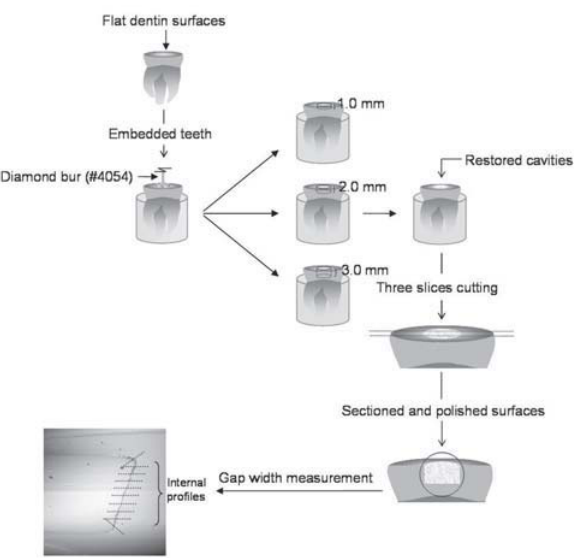
FIGURE 1- Schematic illustration of gap